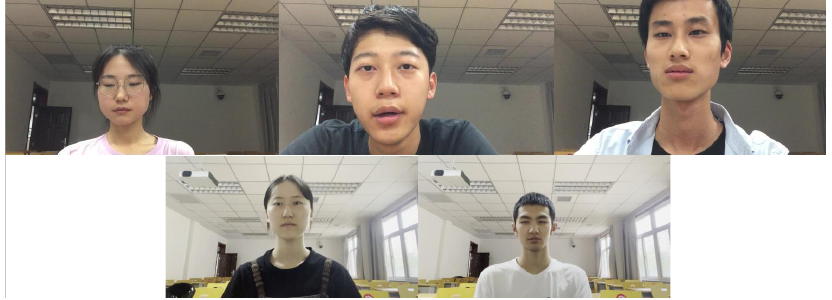
Figure 3. Frame samples of different subjects in different scenarios and at different angles. The first row are samples with darker backgrounds and a closer view; the second row are samples with better-illuminated backgrounds and a distant view.